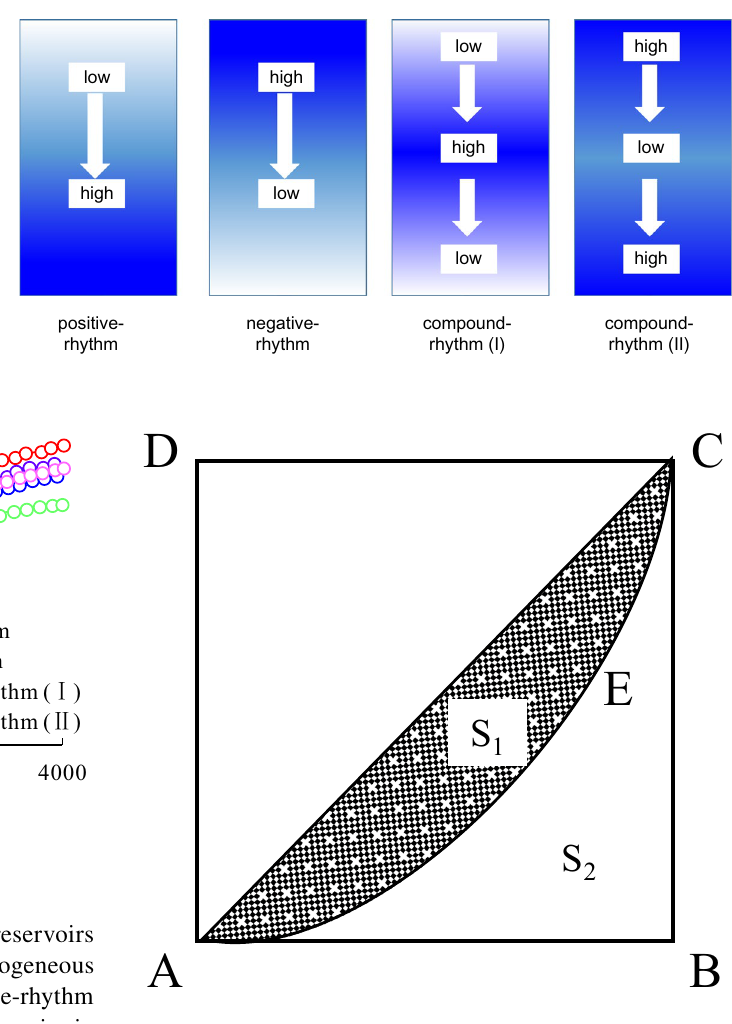
Fig. 9 Schematic diagram of Lorentz